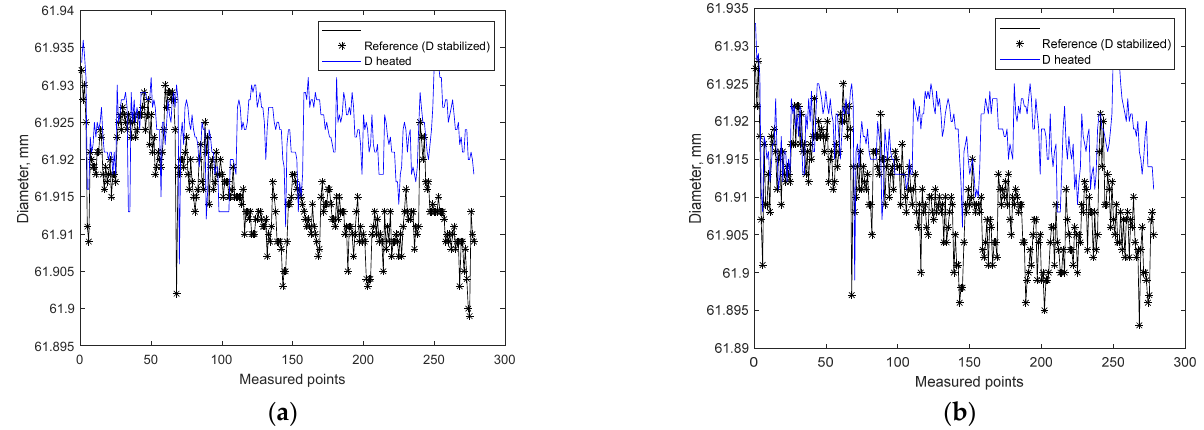
Figure 5. Measured values of diameter: ( a ) data gathered at point A on the workpiece; ( b ) data gathered at point B on the workpiece.